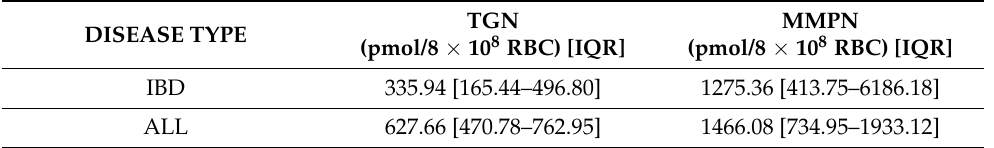
Table 12. Summary of metabolites’ concentrations (median and interquartile range (IQR)) in inflam- matory bowel disease (IBD) and acute lymphoblastic leukemia (ALL)